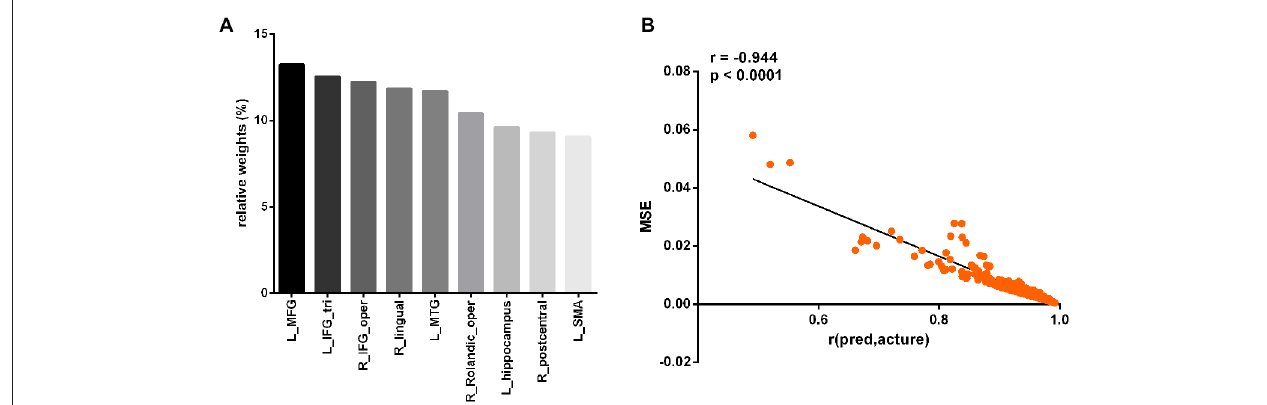
FIGURE 6 | Prediction performance of the linear regression model with the nine regions. The relative weights of the nine regions (A) . The correlation between the r(pred, actual) and MSE (B) . L_MFG, left middle frontal gyrus; L_IFG_tri, pars triangularis of left inferior frontal gyrus; R_IFG_oper, pars opercularis of right inferior frontal gyrus; R_lingual, right lingual gyrus; L_MTG, left middle temporal gyrus; R_Rolandic_oper, pars opercularis of right rolandic area; L_hippocampus, left hippocampus; R_postcentral, right postcentral gyrus; L_SMA, left supplementary motor